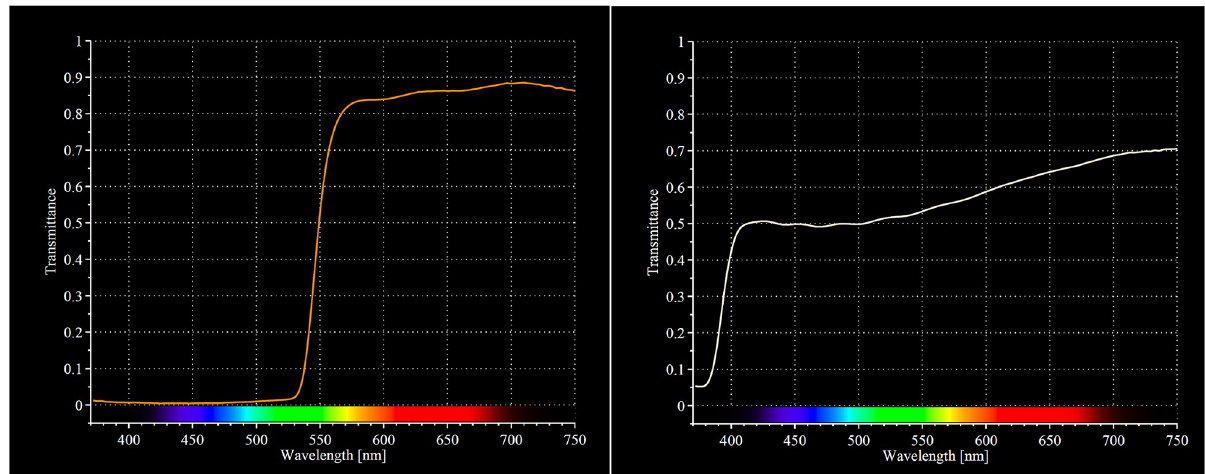
Fig 2. Irradiance spectra from intervention- and control glasses. Note the near complete filtering of blue light spectral irradiance ( < 530 nm) of the BB-glasses.